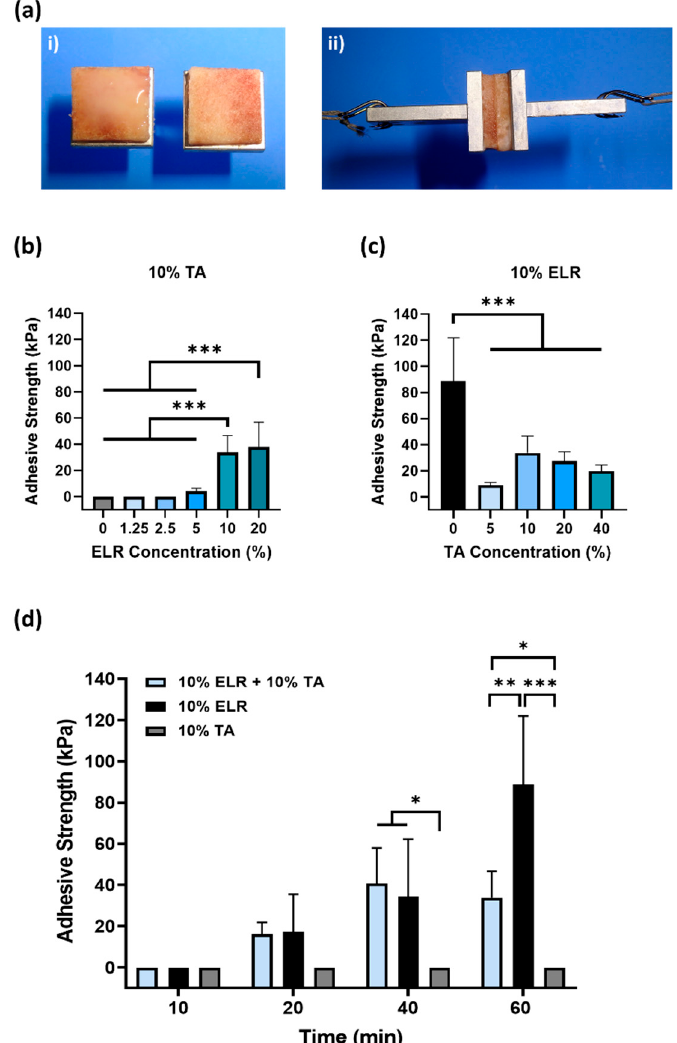
Figure 2. Evaluation of the adhesive properties of ELR-based bioadhesives on bone tissue. ( ai ) Image of the bone tissue bonded to specimen holders; the ELR-based bioadhesive is applied to the bone surface and, subsequently, both bone surfaces are placed in contact with each other. ( aii ) Image of the specimen during tensile testing. ( b ) In fl uence of the ELR concentration on adhesive strength. ( c ) In fl uence of the TA concentration on adhesive strength. ( d ) E ff ect of curing time (10, 20, 40, and 60 min) on the adhesive strength (* p < 0.05, ** p < 0.01, *** p < 0.001). All the data in Figure 2( b – d ) are shown in the Supplementary Materials (Tables S1–S3).